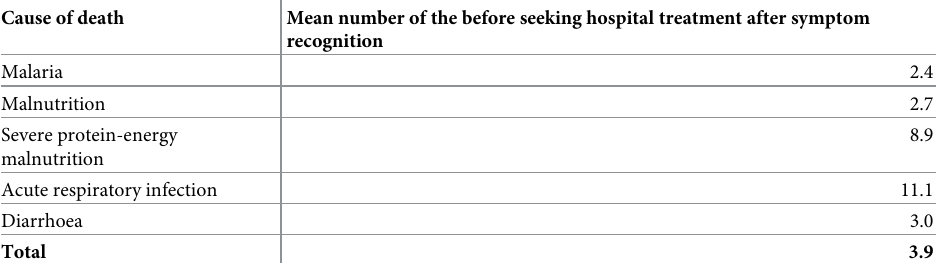
Table 4. Average number of days before sick children accessed medical treatment after symptom recognition using 2005–2015 Iganga-Mayuge verbal autopsy